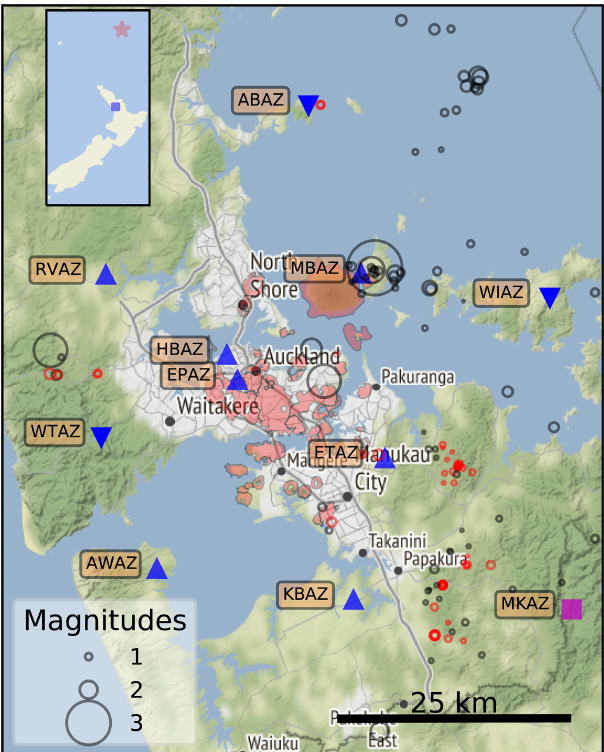
Figure 1. Terrain map of the greater Auckland area from Open- StreetMap (© OpenStreetMap contributors 2020. Distributed un- der a Creative Commons BY-SA License.) with surface expressions of Auckland’s volcanoes in pink from the Determining Volcanic Risk in Auckland (DEVORA) project. The stations of the Auckland Volcanic Seismic Network (AVSN, managed by GeoNet) are pre- sented as blue triangles (surface stations’ triangles point upwards; boreholes point downwards). Station MKAZ (magenta square) is a broadband surface seismic station from the national seismic net- work. Earthquake epicentres (black circles) and quarry blasts (red circles) are from the GeoNet catalogue from 1 January 2011 to 15 June 2020. The inset shows the position of Auckland in New Zealand, as well as the epicentre of an earthquake in the Kermadec Islands region (event ID us60008fl8).